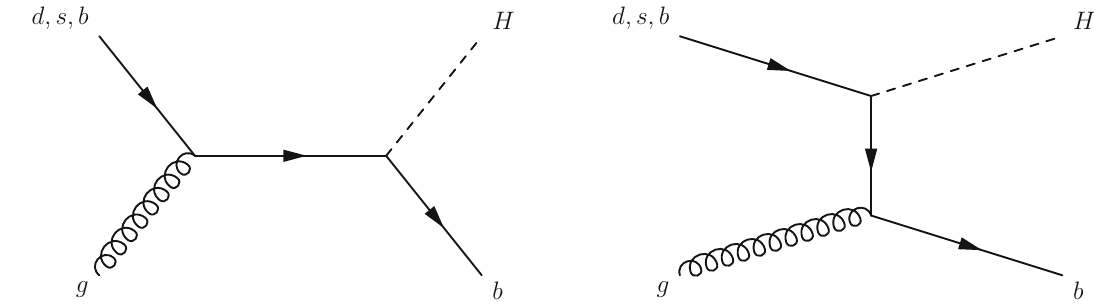
Fig. 7 Diagrams of the bottom quark associated productions of neutral Higgs bosons